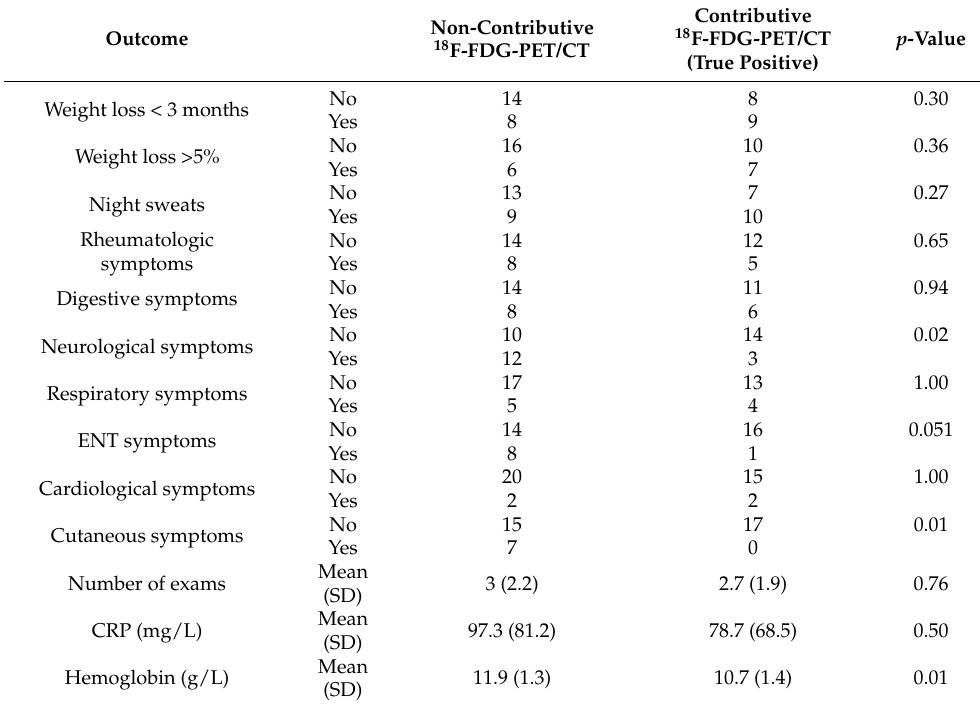
Table 4. Predictors of high-yield 18 F-FDG-PET/CT (univariate analysis). Outcome